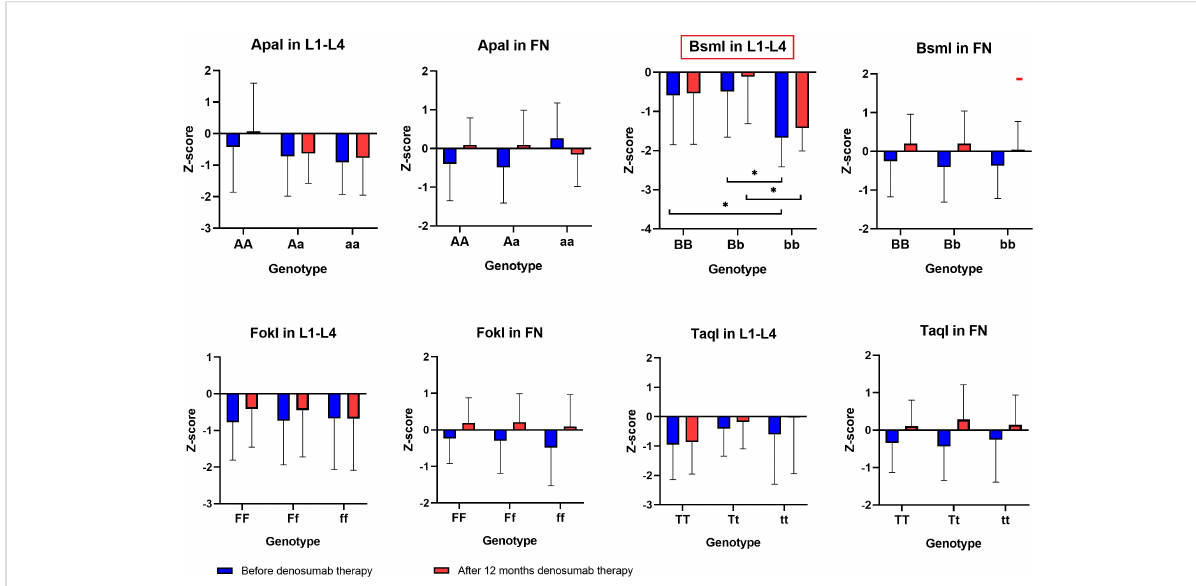
FIGURE 4 Z-score results in the femoral neck and L1 – L4 area for ApaI , BsmI , FokI , and TaqI genotypes of the VDR gene in a studied group before and after one year of denosumab therapy (*P < 0.05).